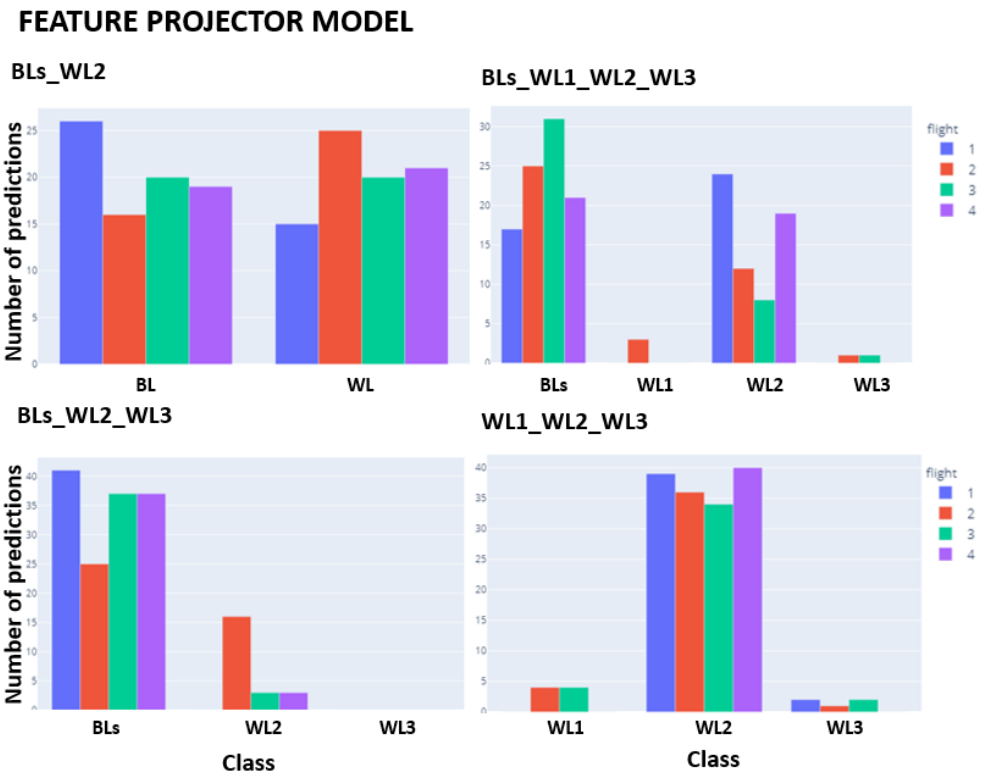
Figure 7. Flight test barplots of WL predictions for the feature projector